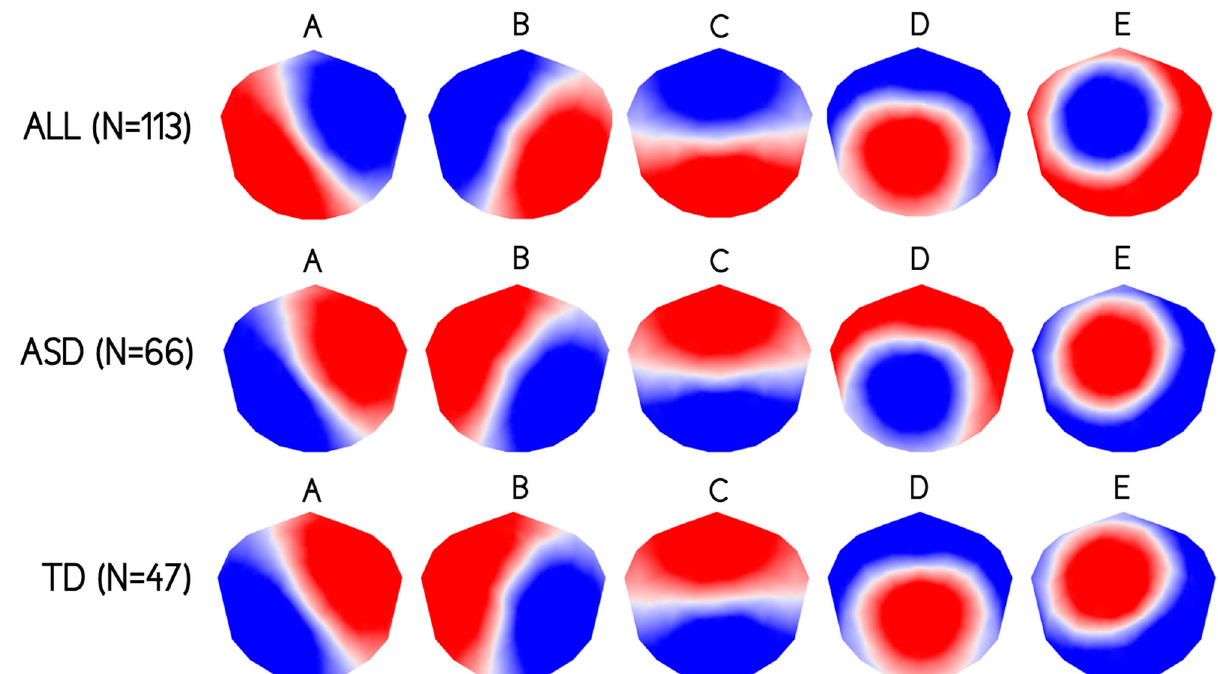
Fig. 1 Microstate topographies. The fi ve microstate topographies identi fi ed in the global clustering across all subjects ( N = 113), the autism spectrum disorders (ASD) group ( N = 66), and the typically developing (TD) group ( N = 47). Polarity of microstate topographies is not relevant meaning that topographies with opposite polarity are considered as the same